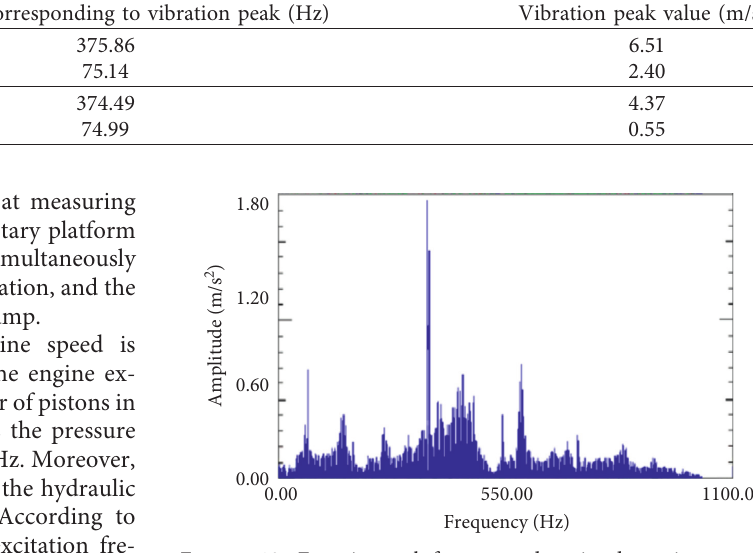
Figure 10: Experimental frequency-domain dynamic response characteristic curves of measuring point 2 in the vertical